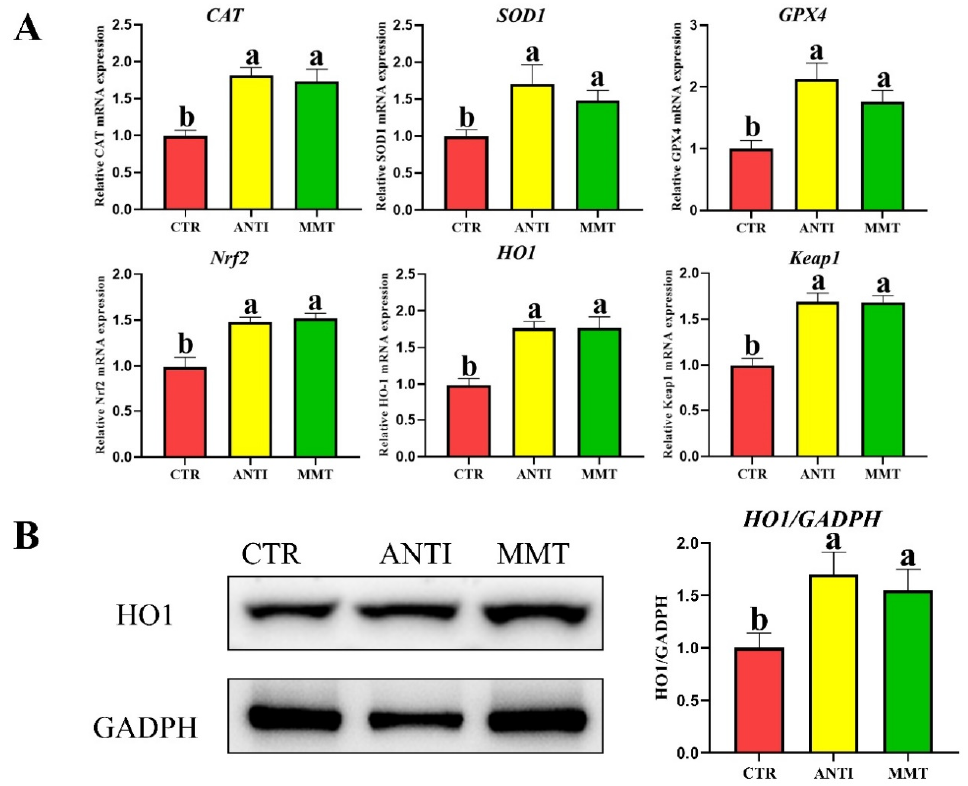
Figure 9. Effects of dietary supplementation with MMT on the relative mRNA and protein expression of antioxidative mediators’ genes in jejunum. ( A ): the relative mRNA of antioxidative mediators’ genes in jejunum. ( B ): the relative protein expression of antioxidative in jejunum. Data are presented as means ± SD (n = 6). a,b Means within a row with different superscripts differ significantly ( p <